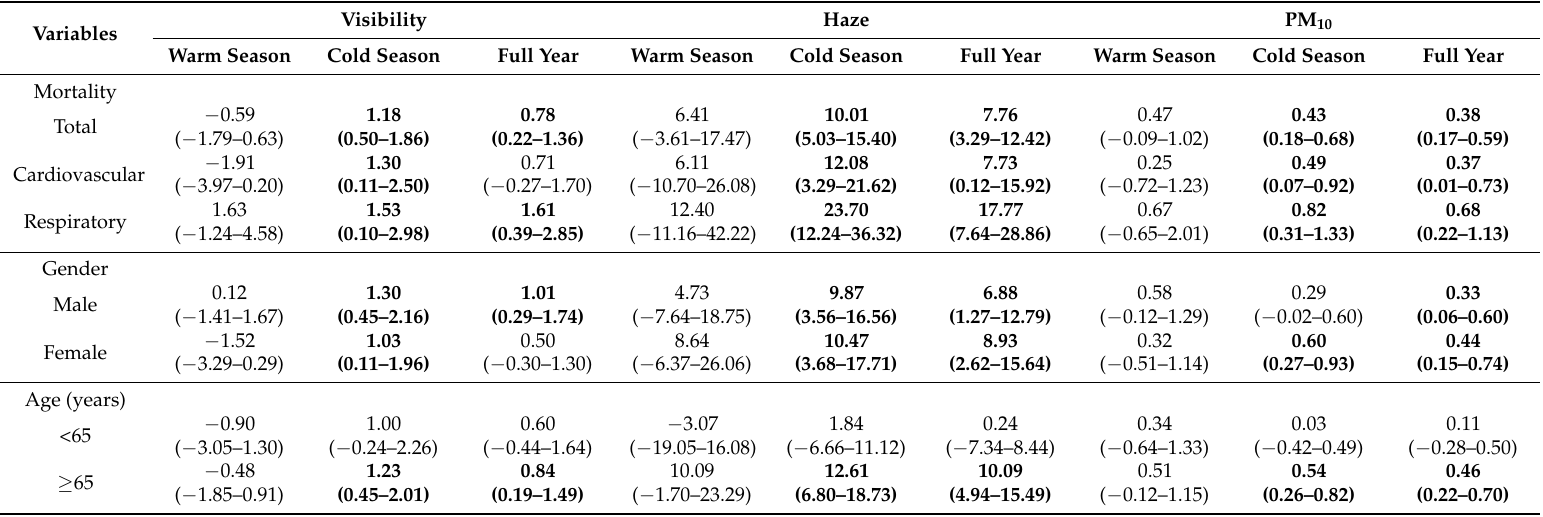
Table 2. The excess risk (ER%, 95% CI) for daily mortality with per 1 km decrease of visibility at lag day 0, per 10 µ g/m 3 increase of PM 10 concentration and in haze days during 0–2 lag days, stratified by season and individual